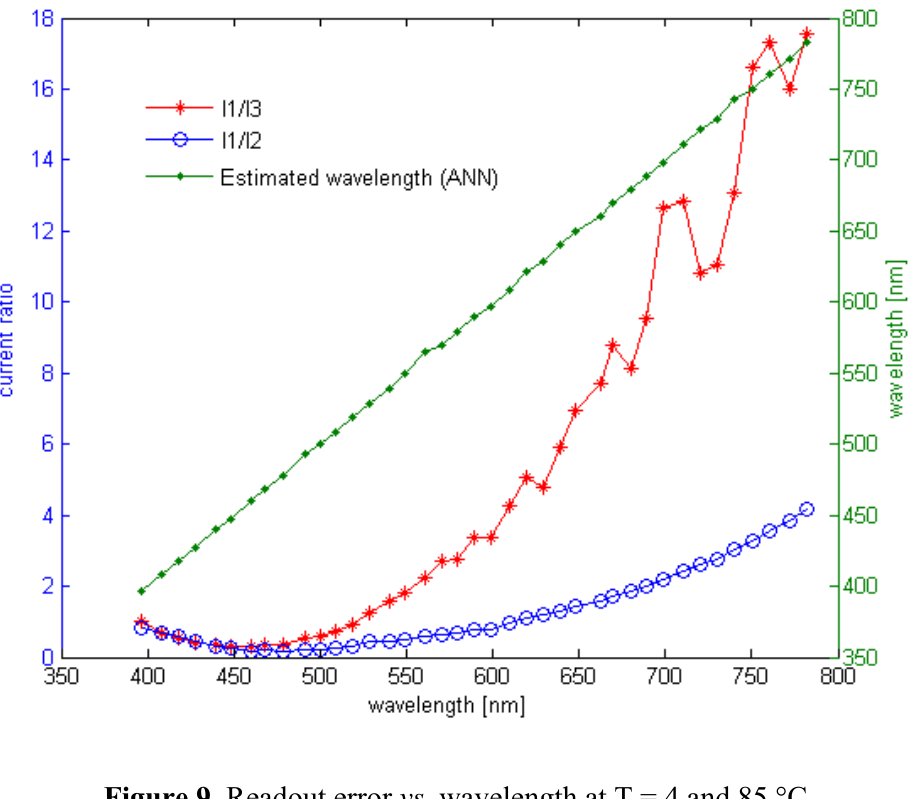
Figure 8. Estimated wavelength, I